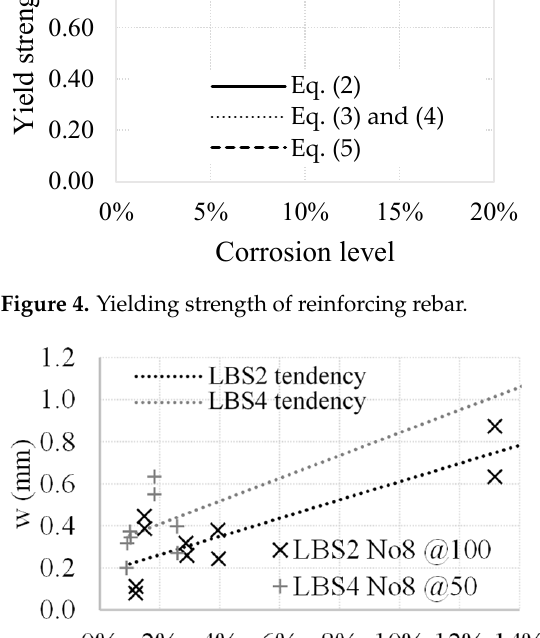
Figure 5. Comparison of crack width, varying the separation between stirrups [20]. From the main results found in experiments by [20], it can determinate that the transverse reinforcement lost its continuity after 0.2 of η . Therefore, the authors considered that an evaluation of residual strength capacity is limited to 0.2 of η . Moreover, the concrete cracking can increment around 1.4 times due to the influences of the transverse reinforcement (Figure 5). This is because the LBS2 specimens had stirrup separations that were double than LBS4 specimens. Corrosion degrades the compressive strength capacity that withstands the concrete due to produced cracking. Shayanfar et al. [29] evaluated the reduced compressive strength ( F cc ) in concretes with different water–cement ratios ( w / c = 0.4, 0.45 and 0.5, Figure 6). Their evaluated specimen only had longitudinal rebars. From these results, an analytical model was proposed to calculate the residual strength of concrete (Equation (6)) considering the corrosion level and water–cement ratio of concrete (Equations